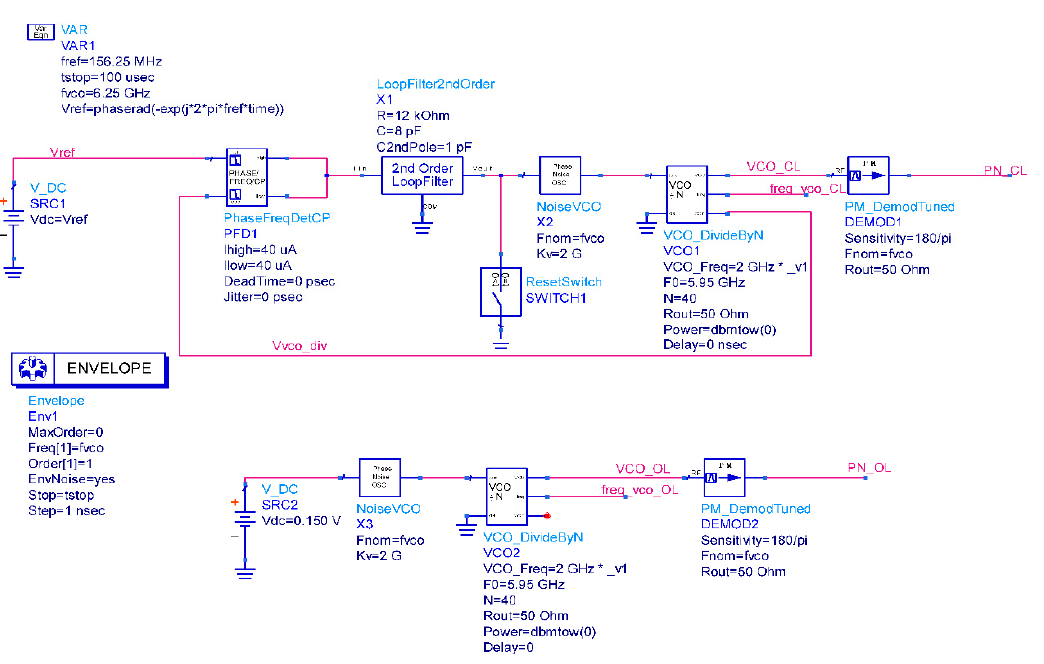
Figure 4. Closed-loop PLL (TOP) and Voltage Controlled Oscillator (VCO, BOTTOM) models in the time and frequency domains.